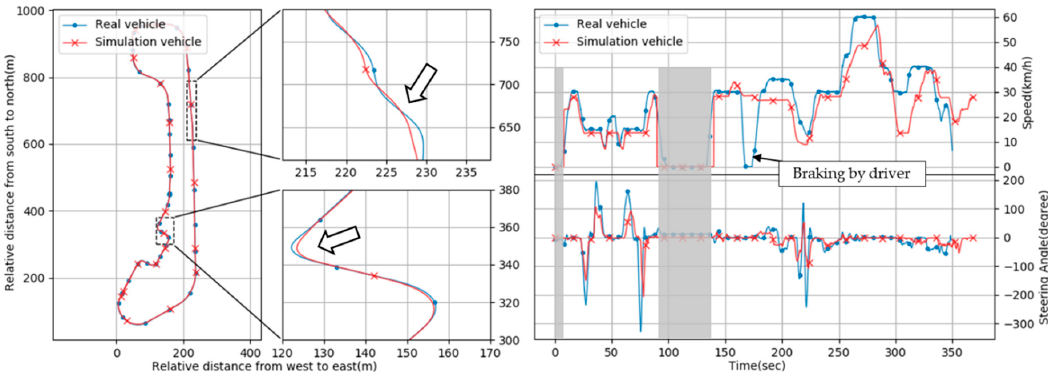
Figure 17. Logging data from real vs. simulation vehicle driving: ( left ) relative driving path, ( right ) speed and steering angle info.